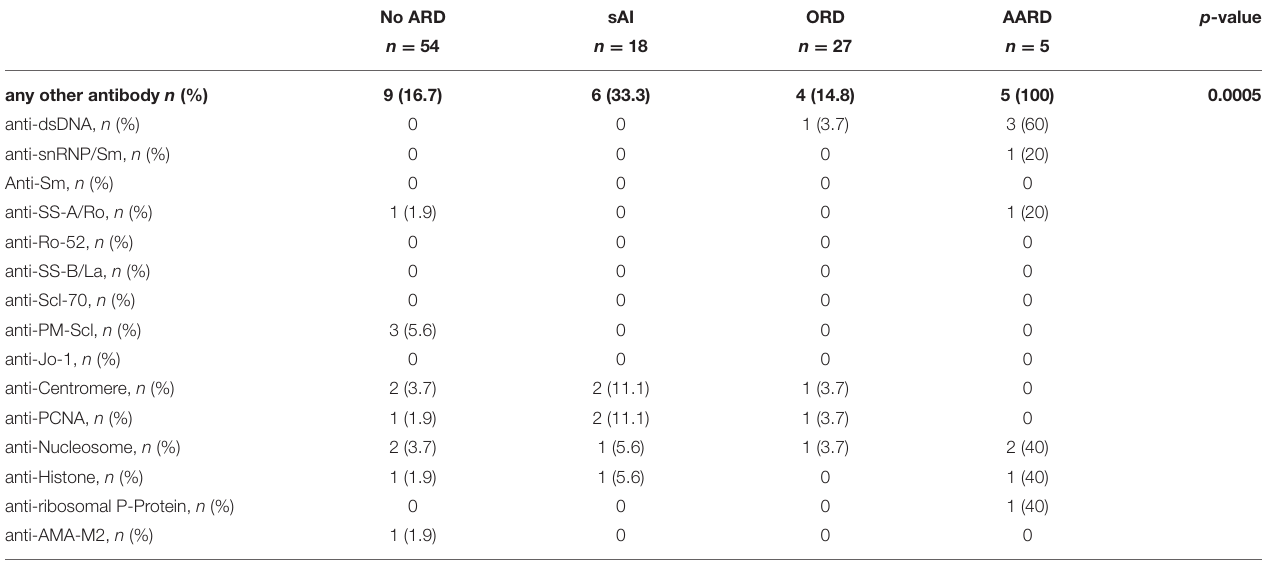
TABLE 2 | Associated antibodies in anti-DFS70-positive patients. No ARD sAI ORD